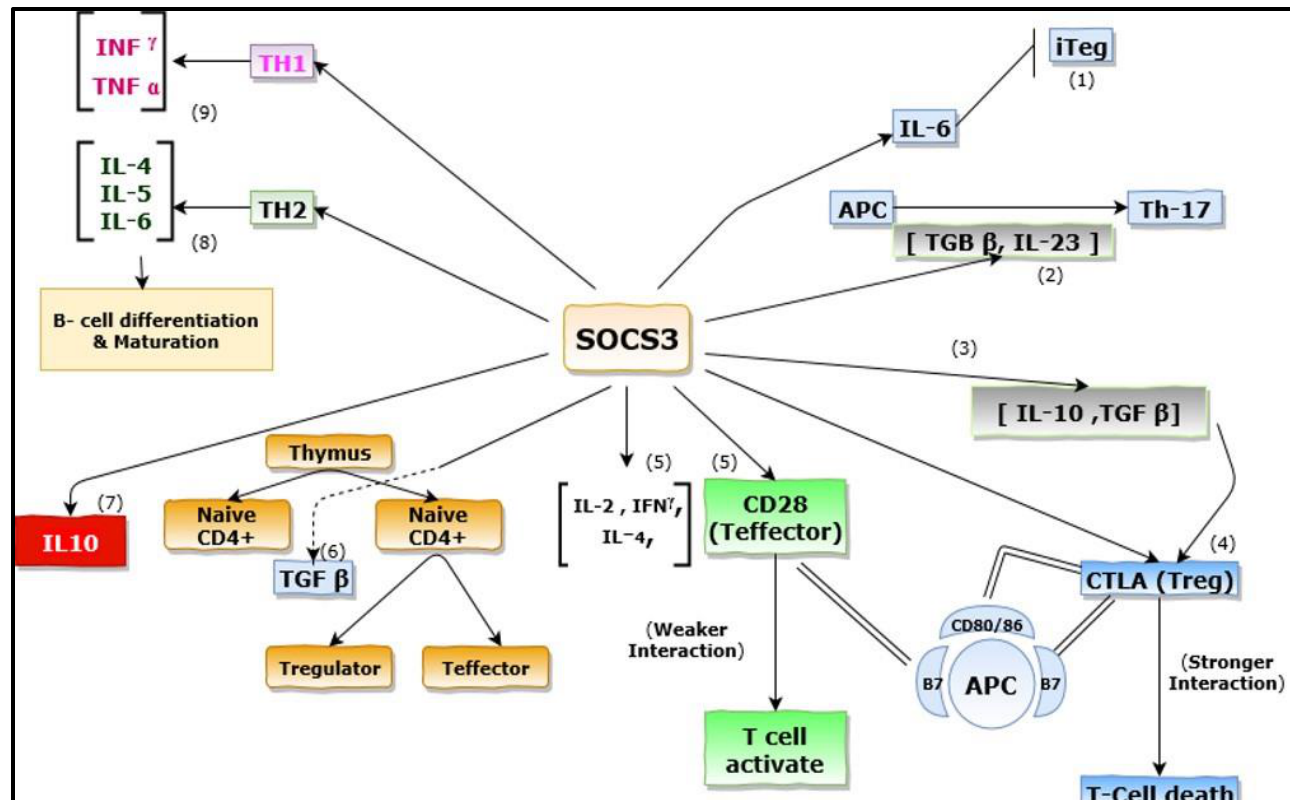
Figure 2. SOCS3 regulation of various cytokines. SOCS3 affecting various interleukins resulted in proliferation of cancer cells by escaping immune